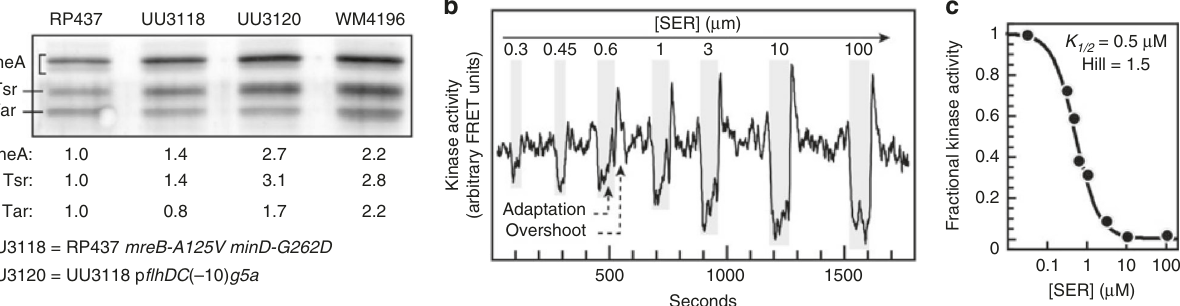
Fig. 3 Chemotaxis proteins and signaling activities in WM4196 minicells. a Tsr, Tar, and CheA levels in WM4196. Cell extracts were prepared and analysed by SDS – PAGE and western blotting as described in the “ Methods ” section. Band intensities were determined by densitometry and normalized to the RP437 values. The entire gel is shown in Supplementary Fig. 2. b FRET analysis of serine signaling in WM4196 minicells. WM4196 minicells expressing the CheY-YFP/CheZ-CFP FRET reporter pair (see the “ Methods ” section) were immobilized on polylysine-coated coverslips and mounted in a microscope fl ow chamber. The horizontal trace follows the ratio of YFP to CFP emission counts, a measure of CheA kinase activity in the cells. Serine stimuli were applied to the cells during the intervals marked by grey rectangles. The magnitude of the drop in YFP/CFP value re fl ects the fraction of CheA activity inhibited by a serine stimulus. Maximal CheA activity in the cells is de fi ned by the YFP/CFP drop in response to a saturating serine concentration (e.g., 10 or 100 µ M). These minicells contain the CheR and CheB adaptation enzymes which act to attenuate a serine-induced drop in kinase activity. A net methylation increase of the serine receptor during the adaptation phase produces a spike or overshoot in kinase activity upon serine removal that rapidly returns to the pre-stimulus kinase activity baseline 33 . c Hill fi t of serine dose – response data. The fractional inhibition values from the experiment in panel b were fi tted to a multi-site Hill function to determine the response K 1/2 , a measure of receptor sensitivity, and the Hill coef fi cient, a measure of response cooperativity 50 . Source data are provided as a Source Data fi